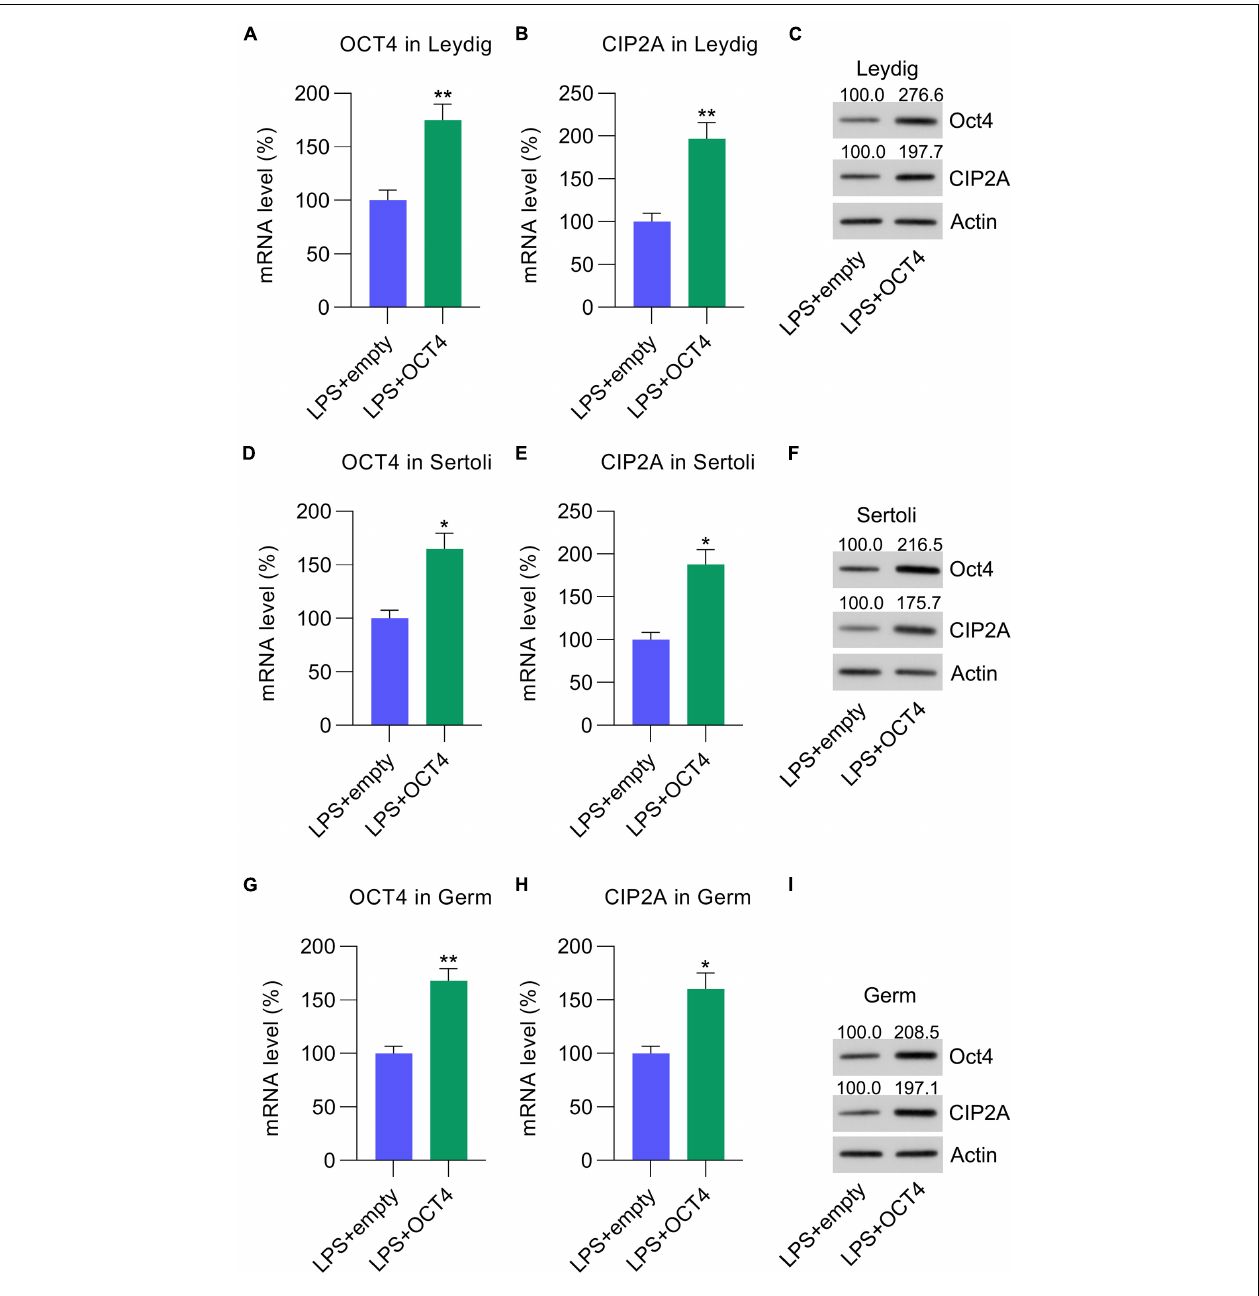
FIGURE 3 | Overexpression of OCT4 in isolated Leydig, Sertoli, and germ cells. Leydig, Sertoli, and germ cells were transfected with pcDNA3-OCT4 or pcDNA3-NC and then incubated with LPS for 12 h. (A,B,D,E,G,H ) RT-qPCR revealed mRNA levels and (C,F,I) WB showed the protein levels of OCT4 and CIP2A in the cells. Data are expressed as the means ± SDs. * P < 0.05, ** P < 0.01, LPS + empty vs. LPS +